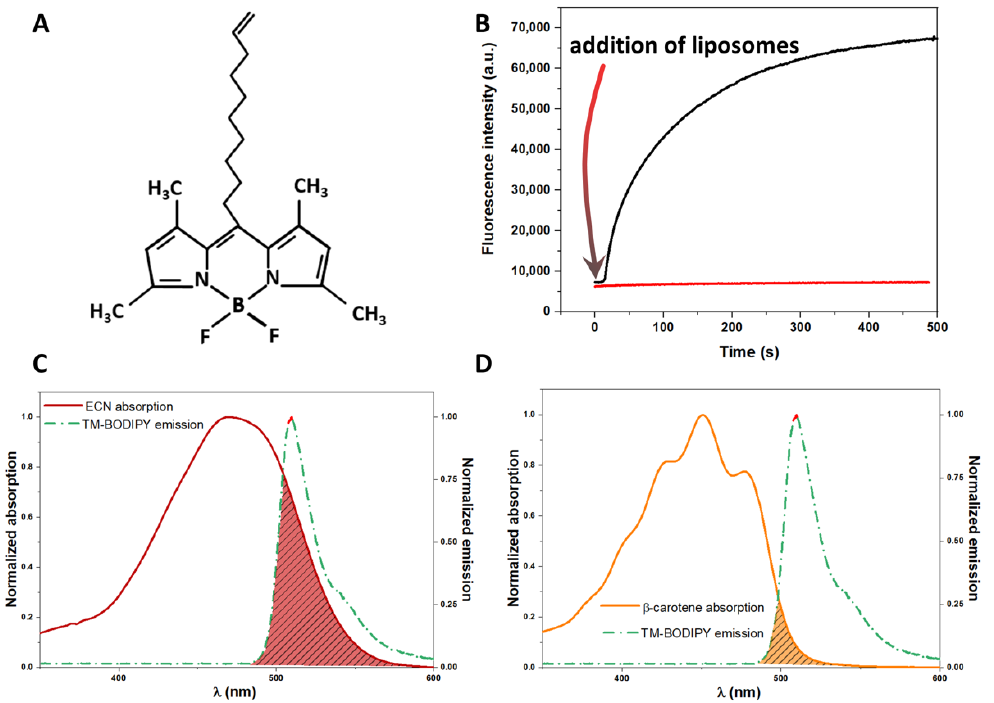
Figure 2. ( A ) Molecular structure of the meso -decene-1,3,5,7-tetramethyl-BODIPY (TM-BODIPY) probe that was used in the present study for membrane labelling; ( B ) Steady-state fluorescence of TM-BODIPY probe after addition of liposomes into aqueous solution; ( C ) The overlap of echinenone (ECN) absorption and TM-BODIPY emission spectra; ( D ) The overlap of β -carotene absorption and TM-BODIPY emission